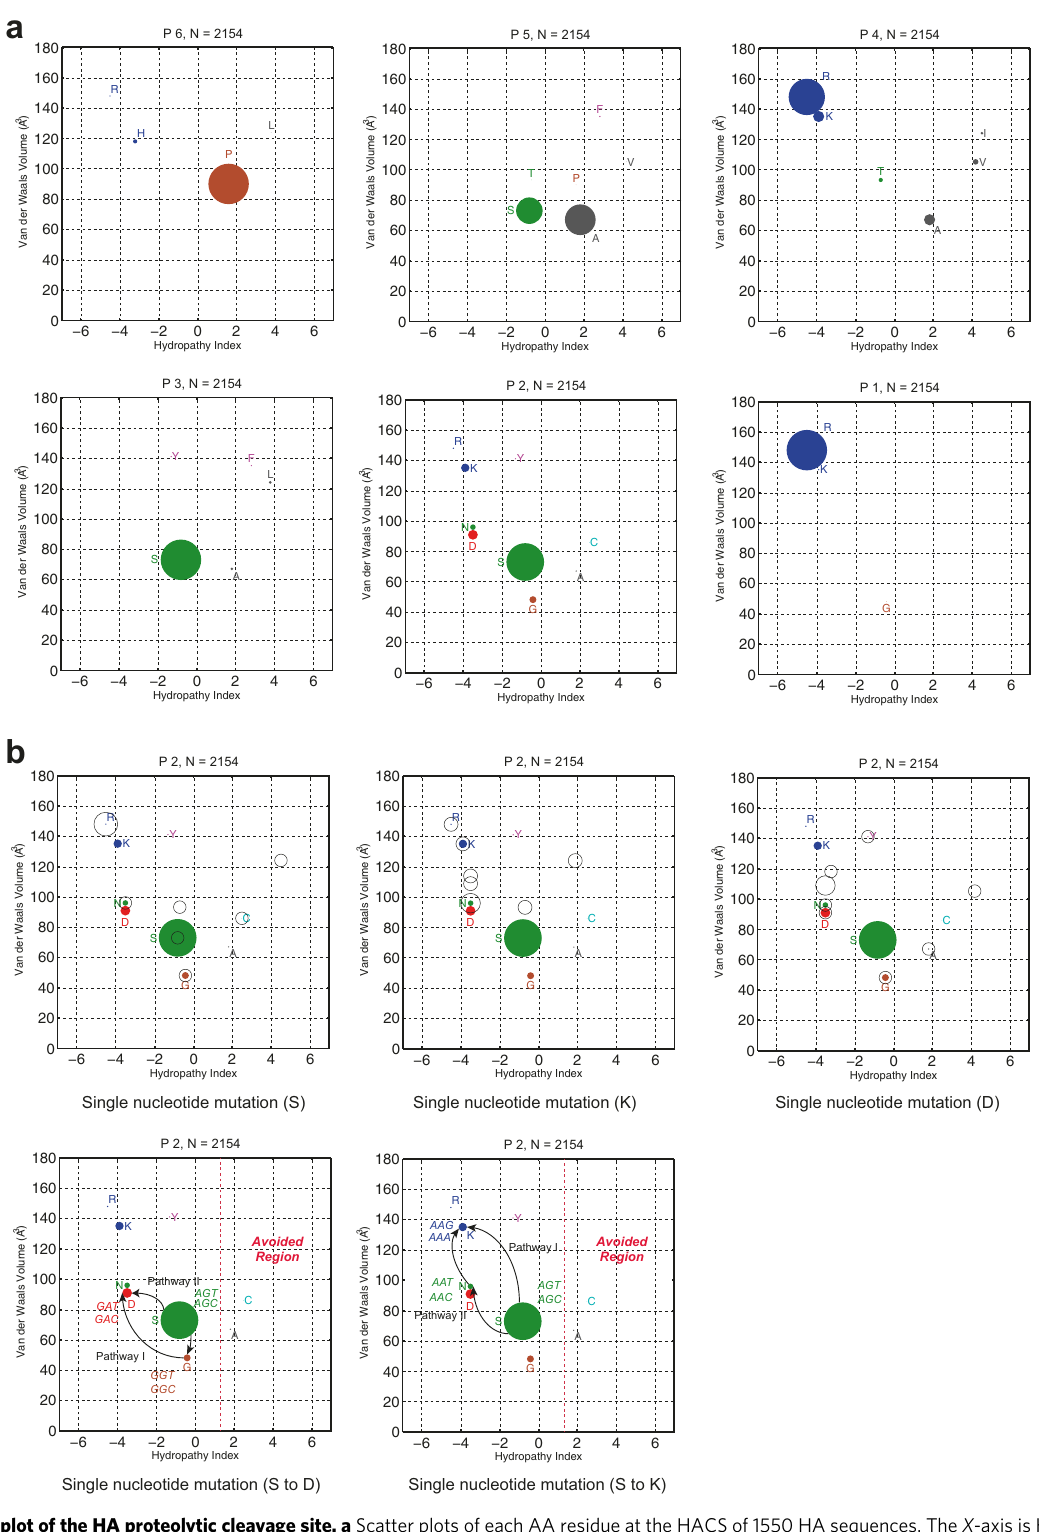
Fig. 6 Scatter plot of the HA proteolytic cleavage site. a Scatter plots of each AA residue at the HACS of 1550 HA sequences. The X -axis is HPI (unitless), and the Y -axis is Y -axis is VdWV (Å 3 ). b Scatter plots for P2 position residues. Potential mutation pathways are shown by an arrow. An “ Avoided Region ” was marked to show the biochemical properties that appear to be unfavorable for the P2 position